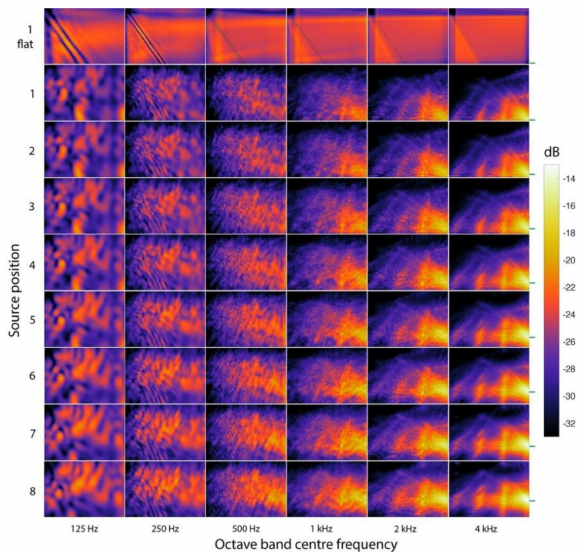
Figure 3. Spatial distribution of the octave-band reflected energy level for the Panna Meena ka Kund simulation over a horizontal plane of 18.1 m × 12.6 m for the eight source positions. The source position is on the right edge of each subplot, indicated by the marker on the right of the 4 kHz band subplots. Values are expressed relative to the emitted sound energy level at 1